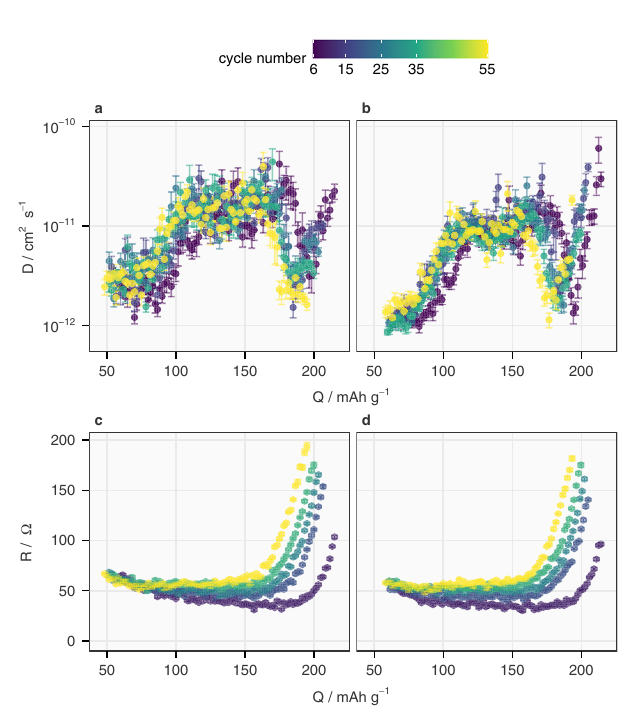
Fig. 7 | Continuous measurements of diffusion coef fi cient and internal resis- tance using the ICI method during long-term cycling. In cycles 6, 15, 25, 35 and 55,theLi-iondiffusioncoef fi cientinNMC811( D )ofCell1derivedbytheICImethod is plotted against the speci fi c capacity ( Q ) during charging and discharging are plotted in a , b , respectively, while the internal resistance ( R ) from the same ICI measurements during charging and discharging are plotted in c , d , respectively. Only values with E ≥ 3.7V, where the ICI method is applicable as discussed above, are shown. The error bars originate from the standard deviation of linear regression.